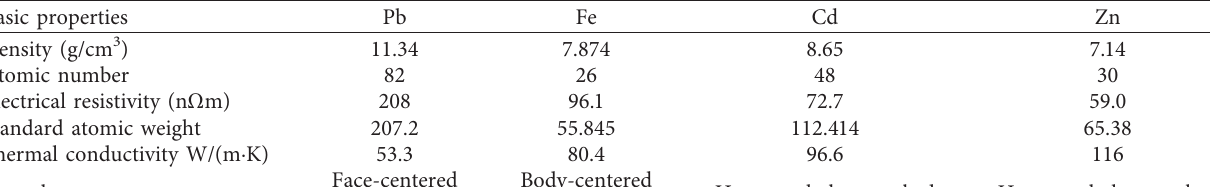
Table 3: The basic properties of the four heavy metals.